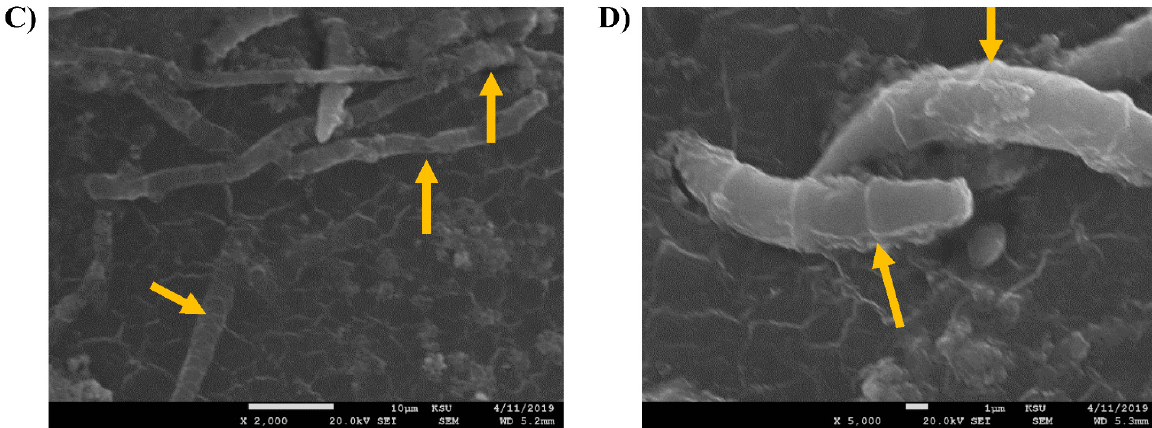
Figure 6. SEM images of F. oxysporum . The tested slides were loaded with F. oxysporum upon treatment with 1% of crude oil. ( A ) (At 1000×, scale bar 10 μ m) and ( B ) (At 4000×, scale bar 1 μ m) are the images of the untreated control sample. ( C ) (At 2000×, scale bar 10 μ m) and ( D ) (At 5000×, scale bar 1 μ m) are the images of fungus treated with 1% crude oil. The yellow arrows in ( A , C ) showed the mycelia of the control and treated fungus, respectively. ( B , D ) showed the spores morphology in the control and crude oil ‐ treated settings.